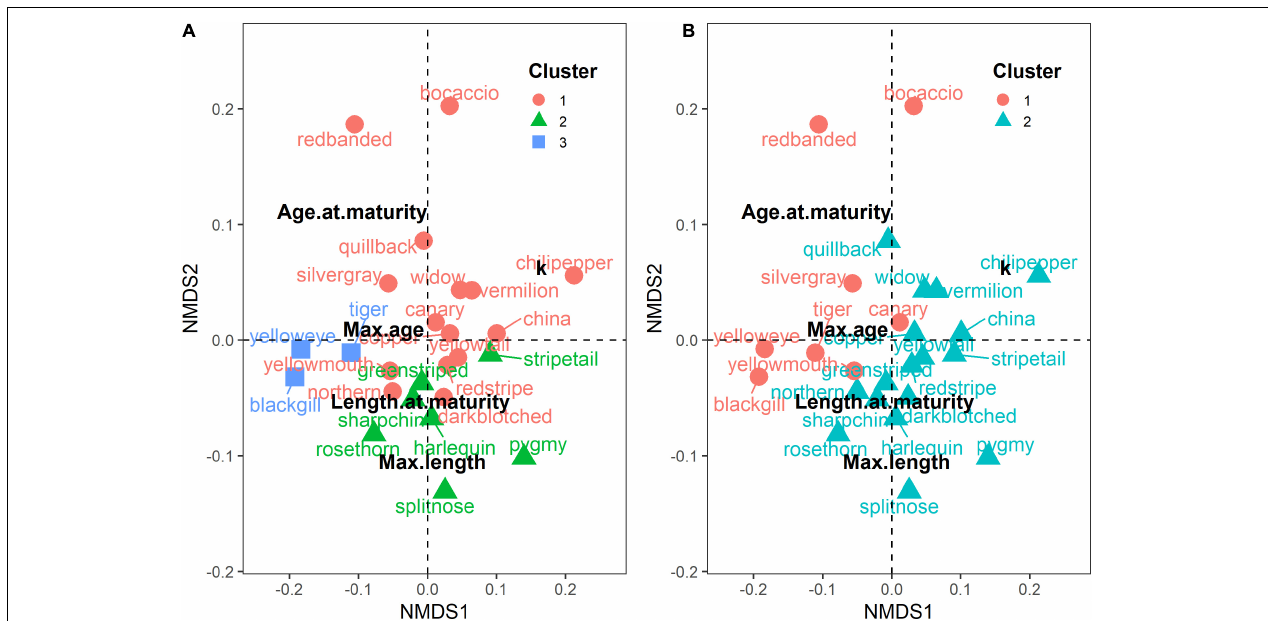
FIGURE 3 | NMDS plot of species’ clusters identified from life history values estimated from FishLife for missing values from (A) Ward’s hierarchical cluster analysis and (B) k -mediods. In Ward’s analysis three or four clusters were supported by the bootstrapping resampling method; results with four clusters separated redbanded and bocaccio into their own cluster.